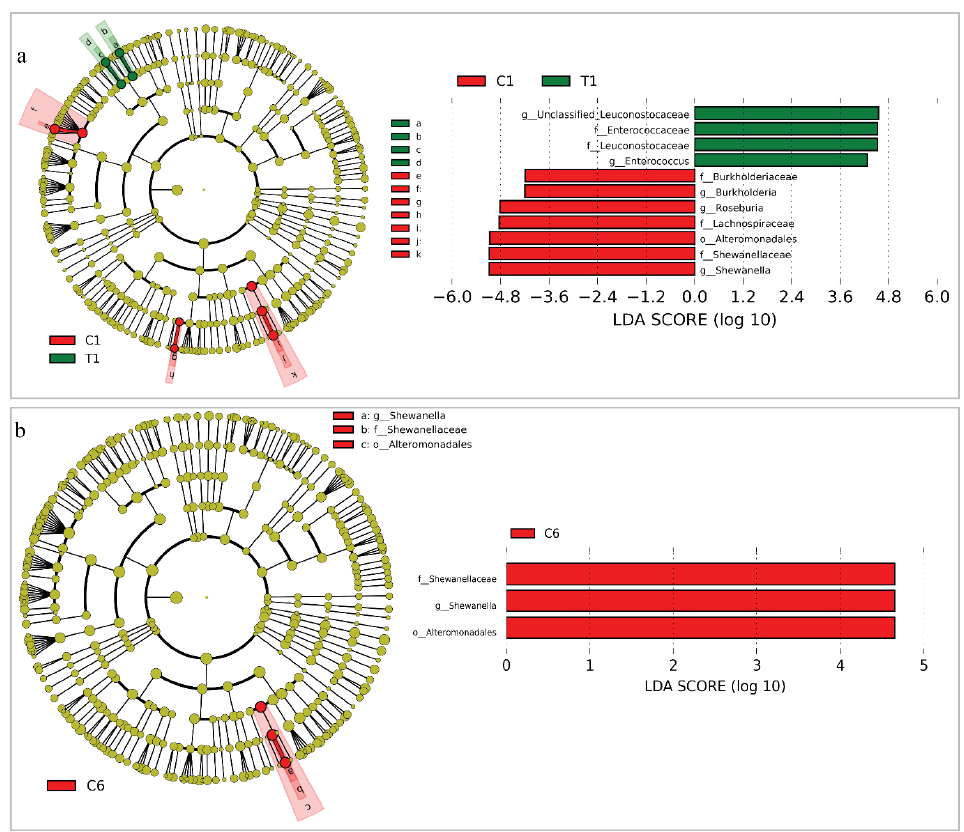
Figure 4. LEfSe analysis using Kruskal–Wallis test ( p < 0.05) with LDA score > 2.0 and cladogram representation of the differentially abundant taxa between C1 and T1 ( a ), and between C6 and T6 ( b ). The size of each node means their relative abundance. The yellow taxa mean no significant dif- ference between the two groups whilst, and the red and green taxa mean significant difference be- tween the two groups.